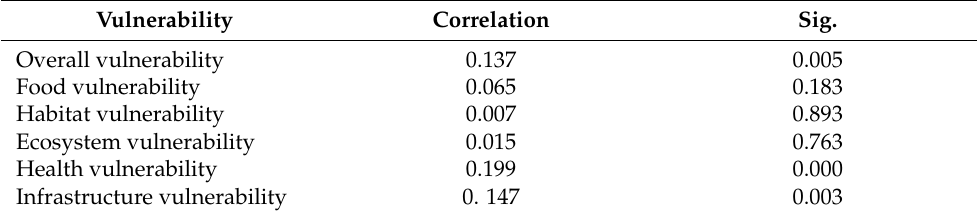
Table 5. Correlation between water vulnerability and other sectors’